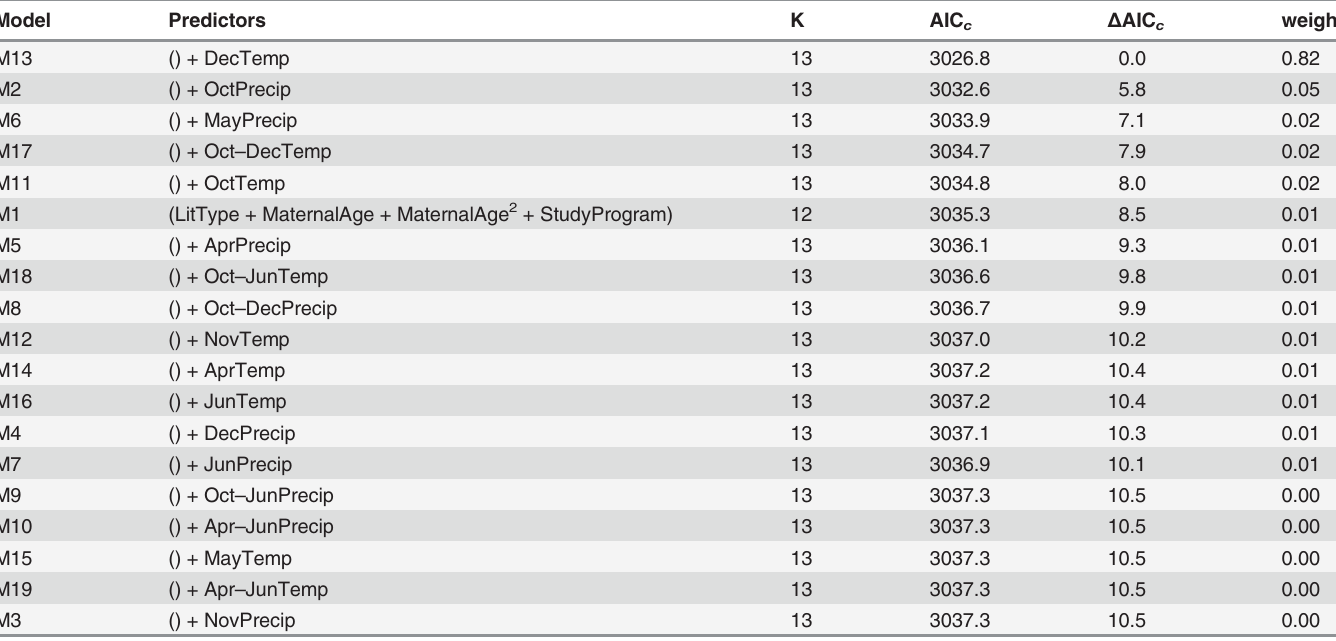
Table 5. Models analyzed and summaries of model selection for the influence of biological variables (litter type, maternal age, study program), and environmental variables on birth mass (kg) of captive white-tailed deer from the Kerr Wildlife Management Area, Kerr County, TX from 1977 – 2012.